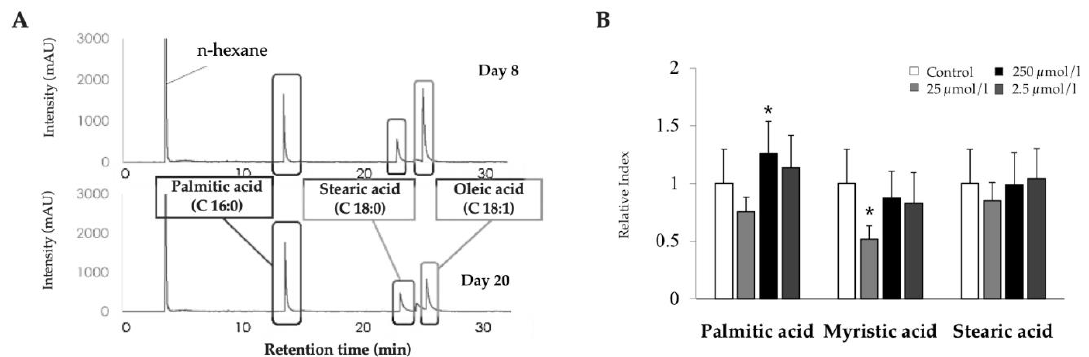
Figure 3. Long-term adipogenic differentiation (LTAD) mediated release of free fatty acids (FFA) from adipocytes, and the influence of saturated fatty acids (SFA) in fat accumulation. The concentrations of three FFA: Palmitic acid, Stearic acid and Oleic acid were measured in the differentiated adipocyte by gas – liquid chromatography ( A ). The 4-day-old confluent adipocytes (2.5 × 10 4 /cm 2 ) were challenged with three different concentrations (as of 250, 25, and 2.5 µmol/l) of each of three SFA for 4 days followed by quantifying the fat accumulation by a TG assay kit ( B ). The asterisk (*) indicated statistical differences of fat accumulation of SFA treated adipocyte when compared to untreated control with significance level of p < 0.05.